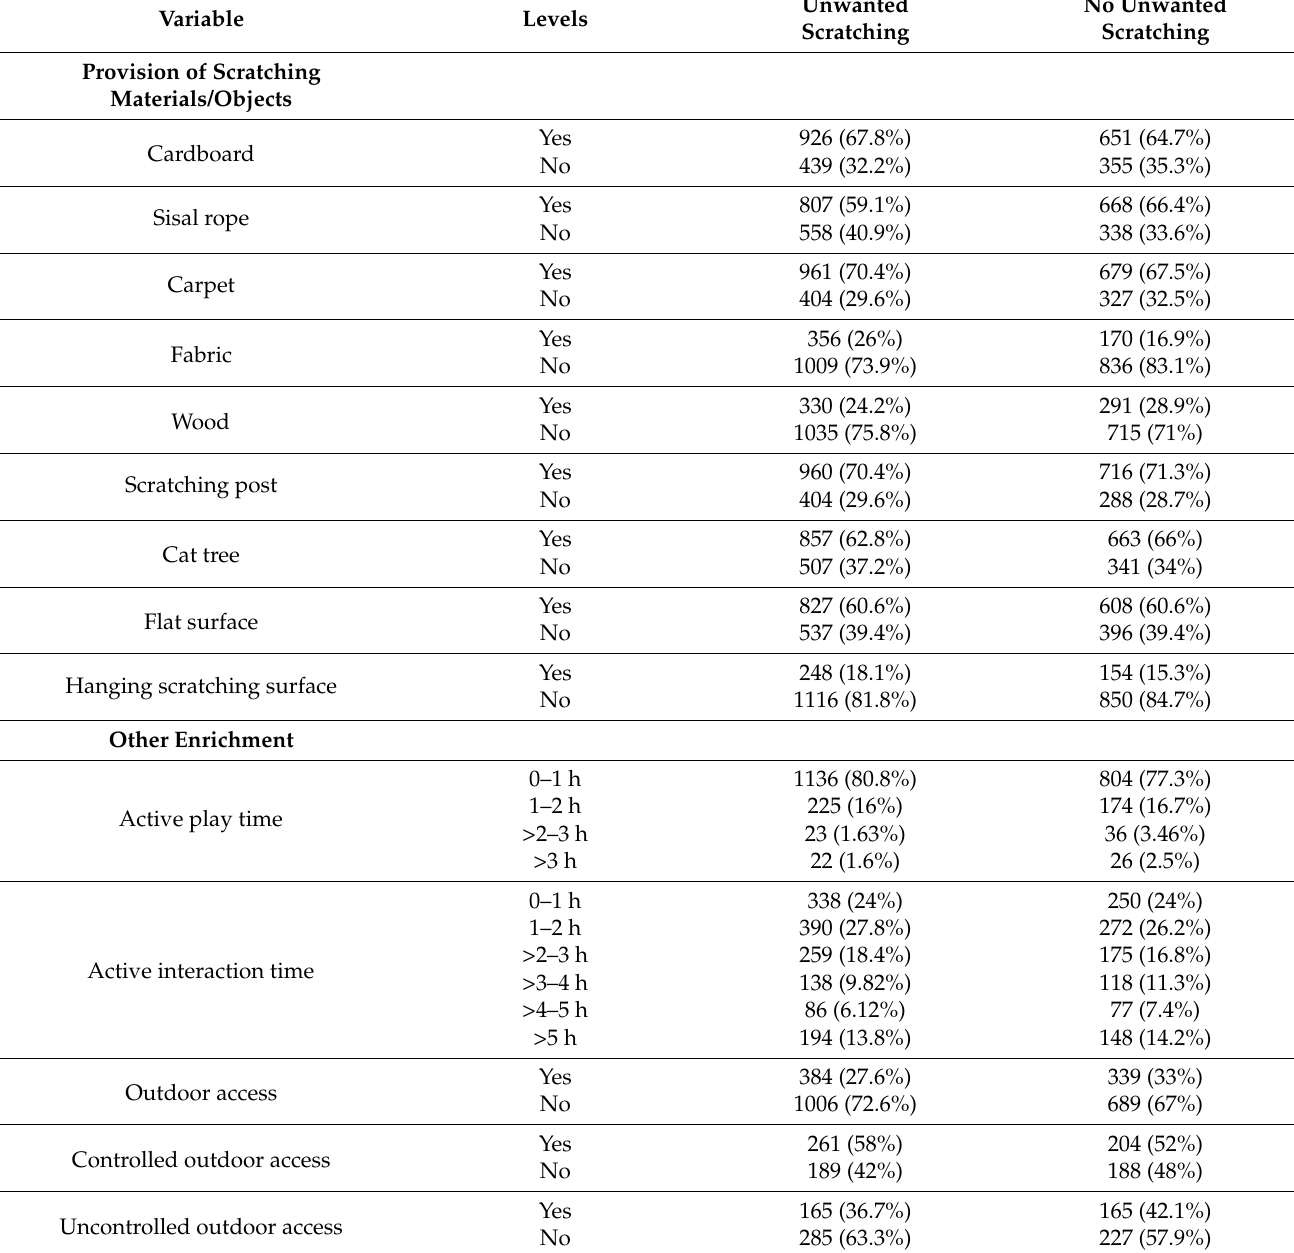
Table 2. Summary statistics comparing enrichment provided by cat owners with cats who show either unwanted scratching behavior ( n = 1406) or no unwanted scratching behavior ( n =